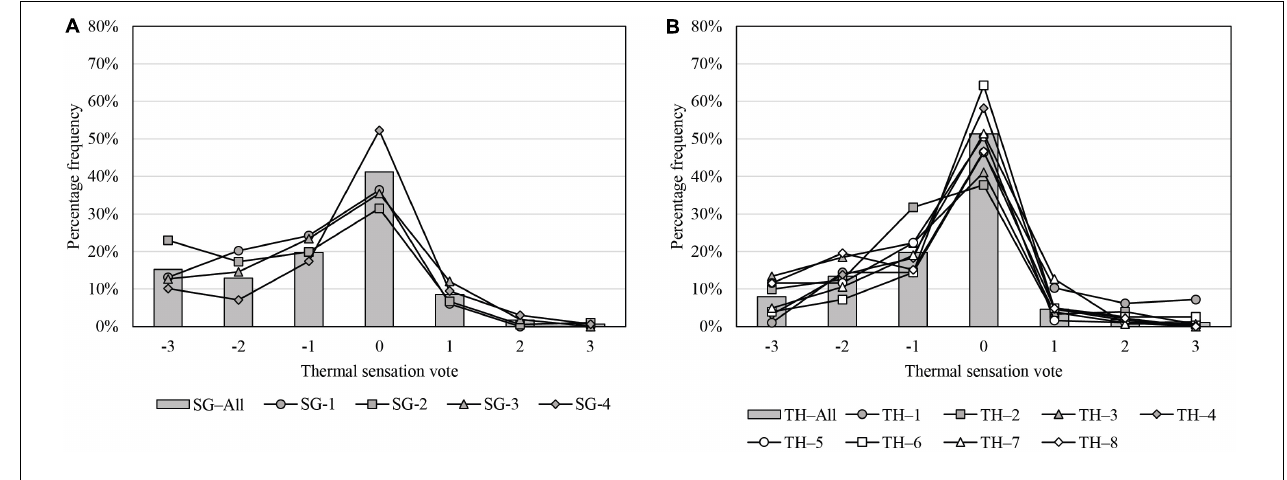
FIGURE 2 | Thermal sensation votes: (A) Singapore and (B) Thailand.